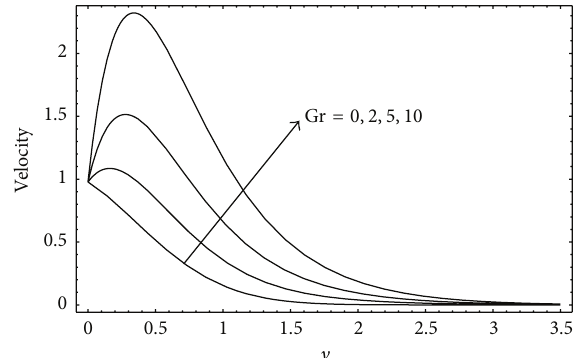
Figure 5: Velocity profiles for different values of Gr when 𝑡 = 0.2, 𝑅 = 3, Pr = 0.71, Gm = 2, Sc = 0.78, 𝛾 = 1 , and 𝜔 = 𝜋/3 .